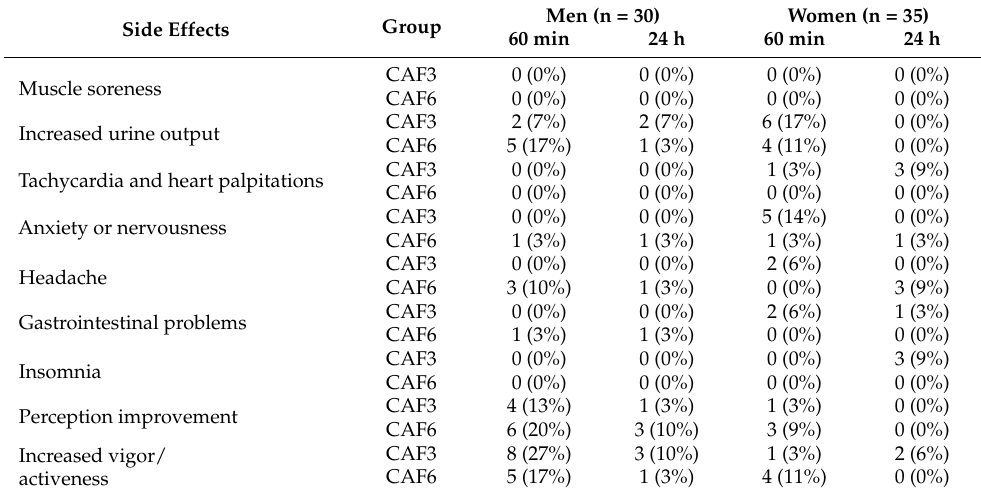
Table 6. The dose and sex-dependent number of participants who reported side effects immediately after the test protocol and 24 h